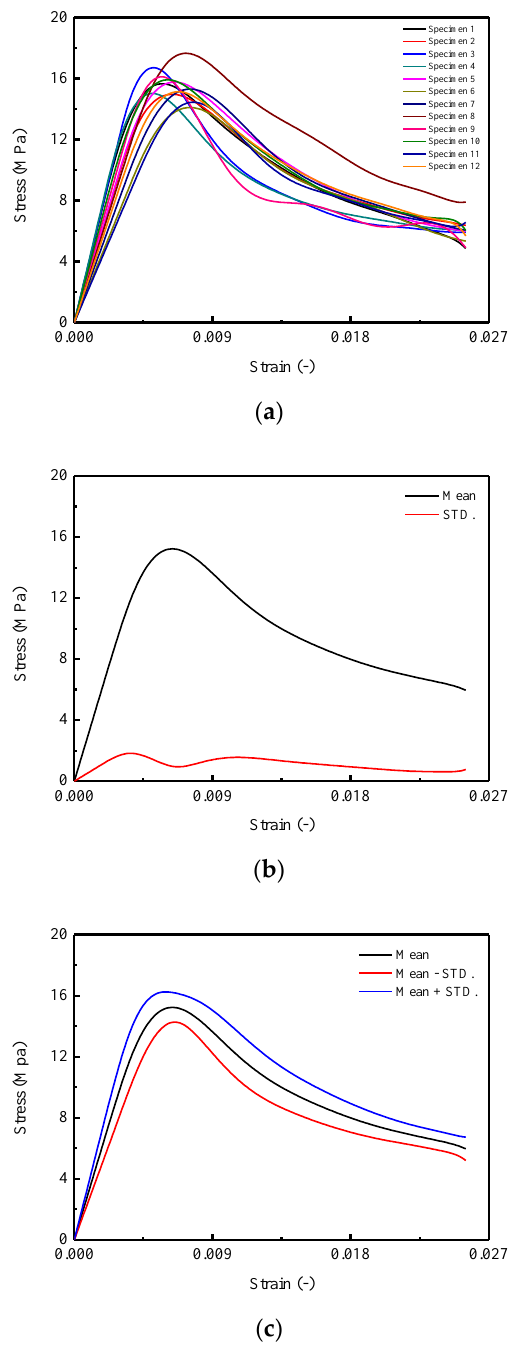
Figure 5. Complete stress–strain curve of CA mortar: ( a ) Stress–strain curves of CA mortar specimens; ( b ) Mean and standard deviation for stress–strain curves; ( c ) Mean ± STD. for stress–strain curves.